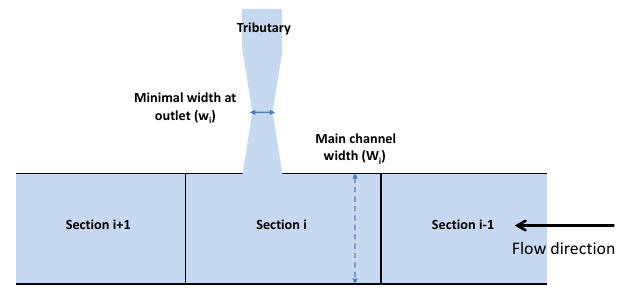
Figure 3. Modification of the channel’s width due to incoming trib- utaries. For segment i, the adjusted width ( W (cid:48) tracting the minimal width of the tributary at the outlet ( w i ) from the main channel width ( W i )